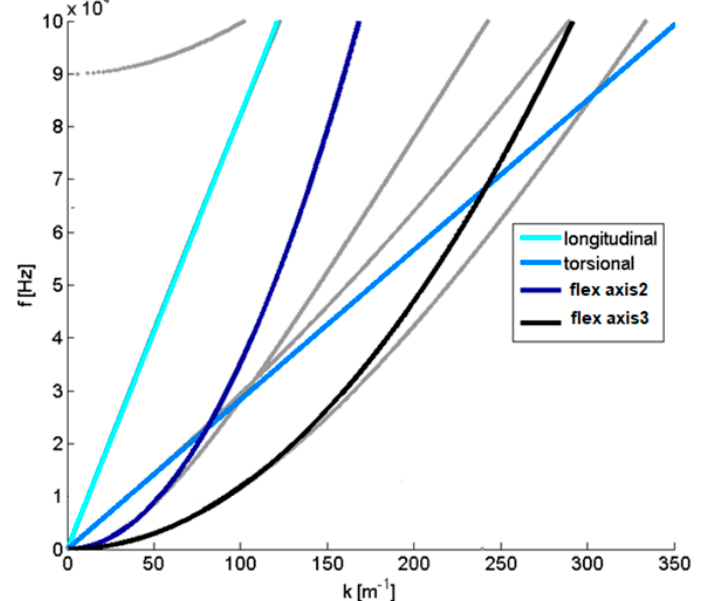
Figure 13. Comparison made between the analytical beam model [11] (color lines) and SAFE [28] solution (grey lines). (l: longitudinal, t: torsional, f2: flexion around Axis 2, f 3 : flexion around Axis 3. Notice that in this graph the wave number is defined as k = 2 π / λ [m -1 ].